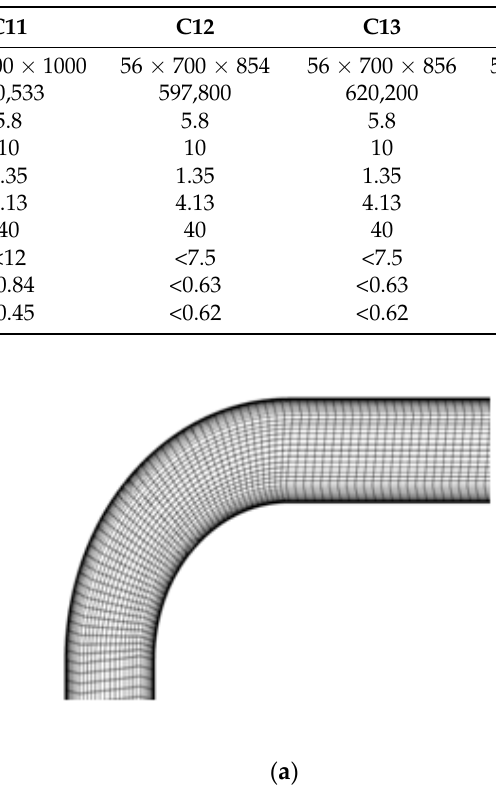
Figure 9. Example of mesh case C22. ( a ) Axial direction, middle plane; ( b ) radial direction, pipe entry.